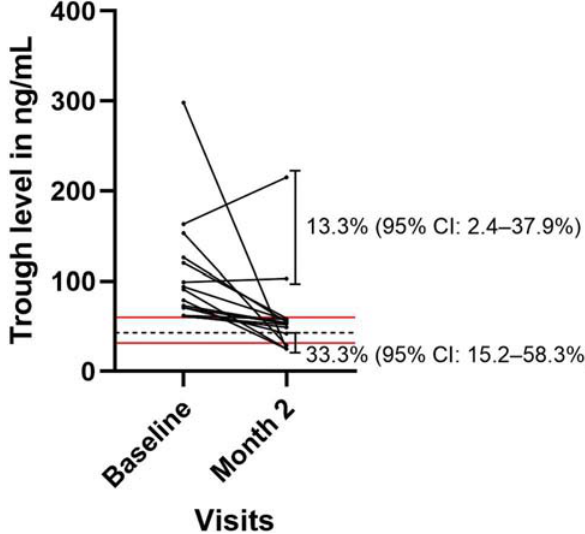
Fig. 3 Change in trough rivaroxaban levels across visits in patients with levels above the upper 20th centiles at baseline ( (cid:4) 60.2 ng/mL). Solid, red horizontal lines represent the 20th and 80th percentiles of peak levels observed at baseline. Dashed, black horizontal lines represent the median trough level at baseline (43.0 ng/mL). Proportions of patients with levels remaining above or below the extreme 20th percentiles at month 2 are shown by the respective vertical capped lines. CI, con fi dence